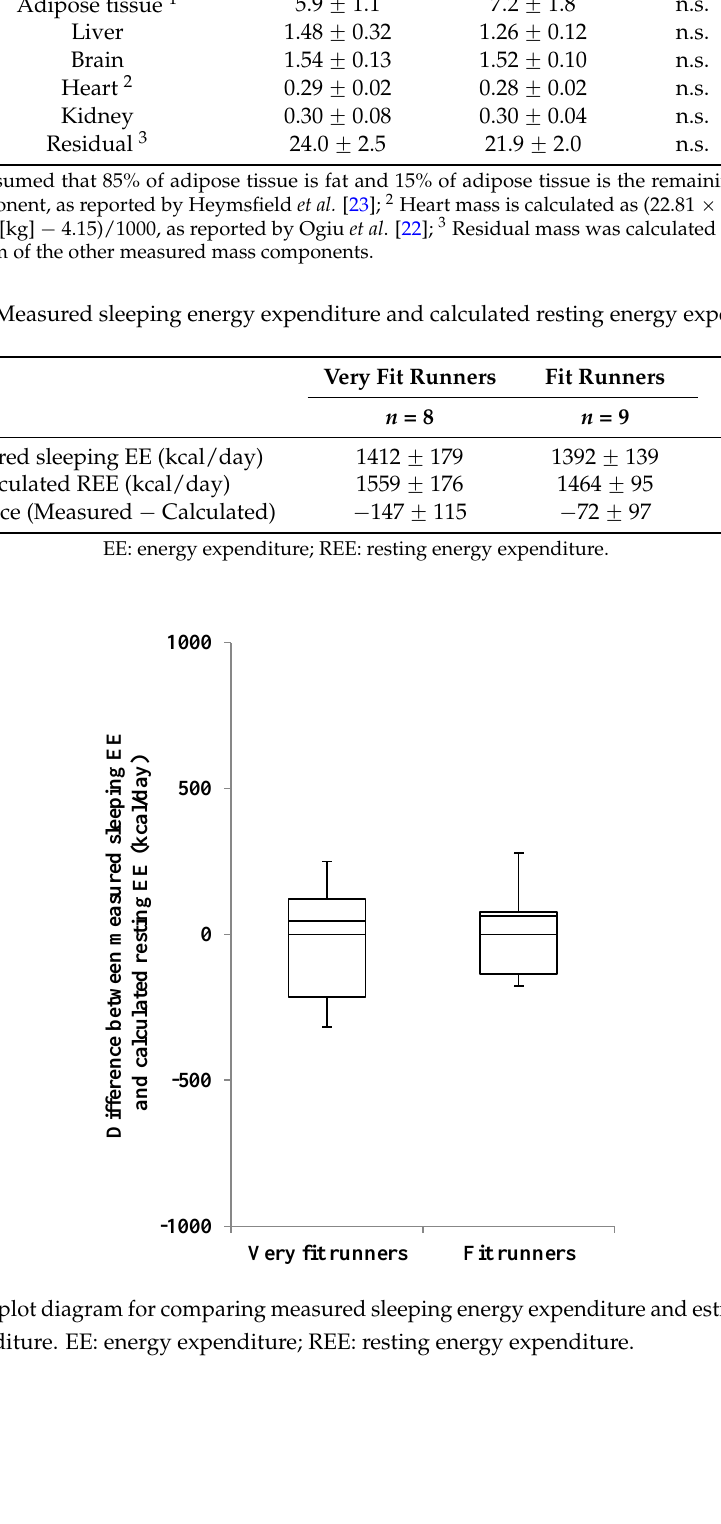
Figure 2. Relationship between the measured sleeping energy expenditure and calculated resting energy expenditure. EE: energy expenditure; REE: resting energy expenditure.